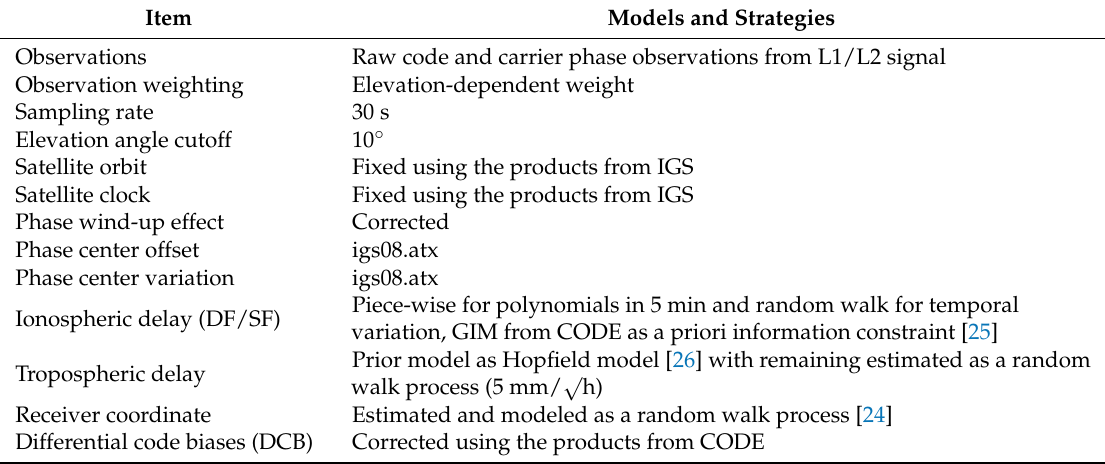
Table 1. Summary of data processing models and strategies for GPS DF and SF